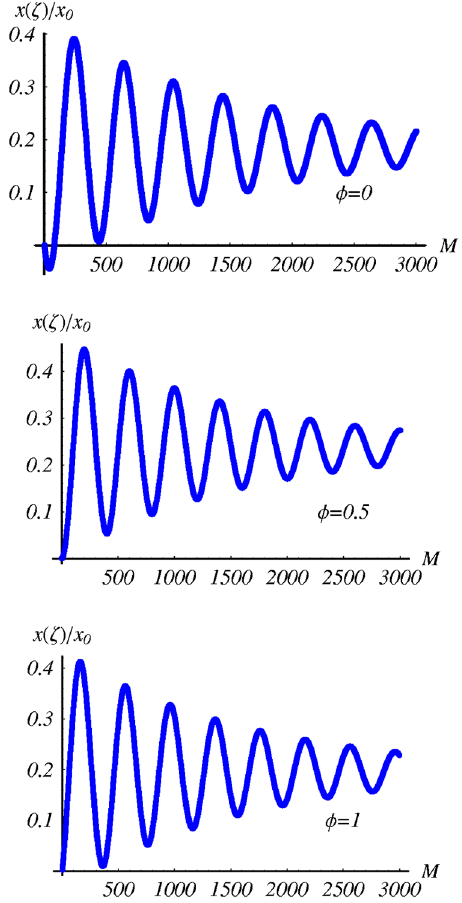
FIG. 6. (Color) Normalized displacement of a train of finite- length bunches with / (cid:7) 0 : 1 , Q (cid:7) 10 4 , (cid:8) (cid:7) 100 : 5 ’ , " (cid:7) 0 : 2 , !. (cid:7) 4 : 005 ’ , and (cid:4) (cid:7) 1 . The upper, middle, and lower figures are for the front, middle, and tail of the bunches,